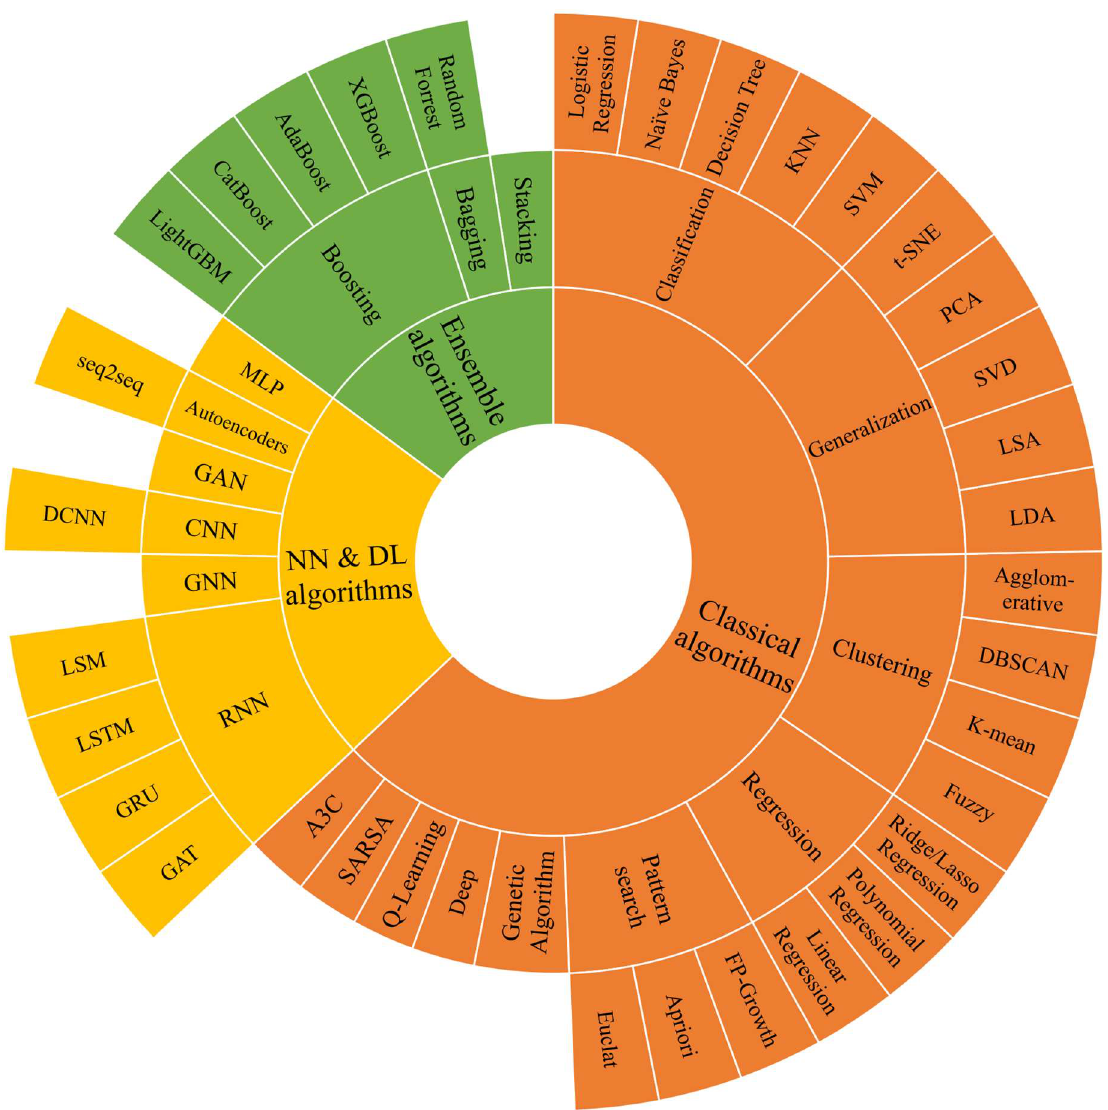
Figure 3. ML algorithms’